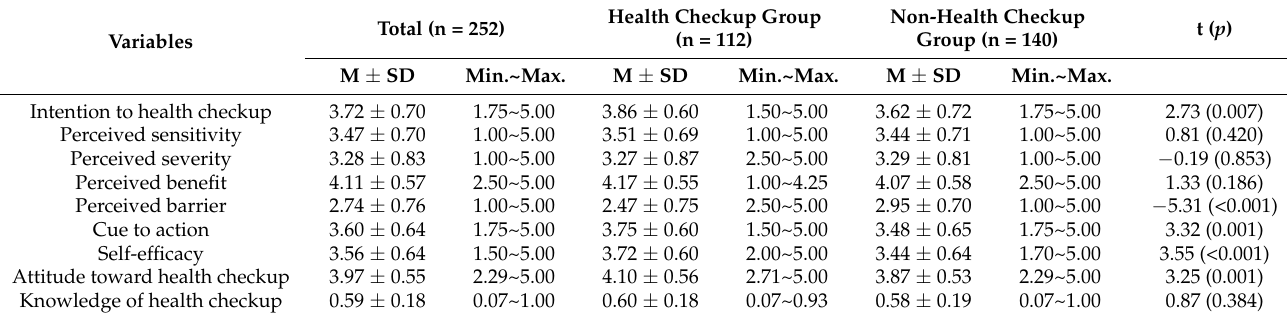
Table 2. Descriptive statistics of the variables (n =